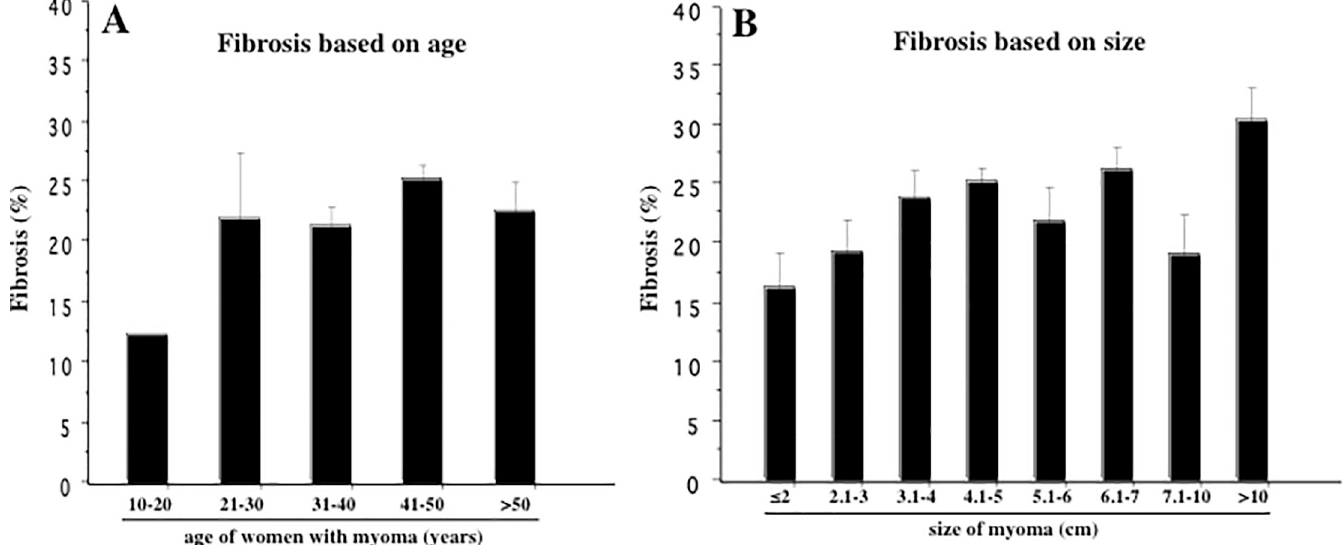
Fig 8. (A) Computer-captured image analysis of fibrosis in the biopsy specimens derived from combined myoma and myometria of women with different types of uterine myoma based on age of the patients. The percentage of fibrosis in their 30 th , 40 th and 50 th years appears to be higher comparing to women in their 10 th and 20 th years of age. ( B ). Analysis of fibrosis in similar biopsy specimens demonstrated a size-dependent increase in the percentage of fibrosis in women with combined SMM, IMM and SSM. Kruskal-Wallis test indicated the higher percentage of fibrosis in myoma/myometria with increasing size (4.1-5cm, 6.1–7.0cm and > 10cm) comparing to those with other sizes of myoma. The results are expressed as mean ±